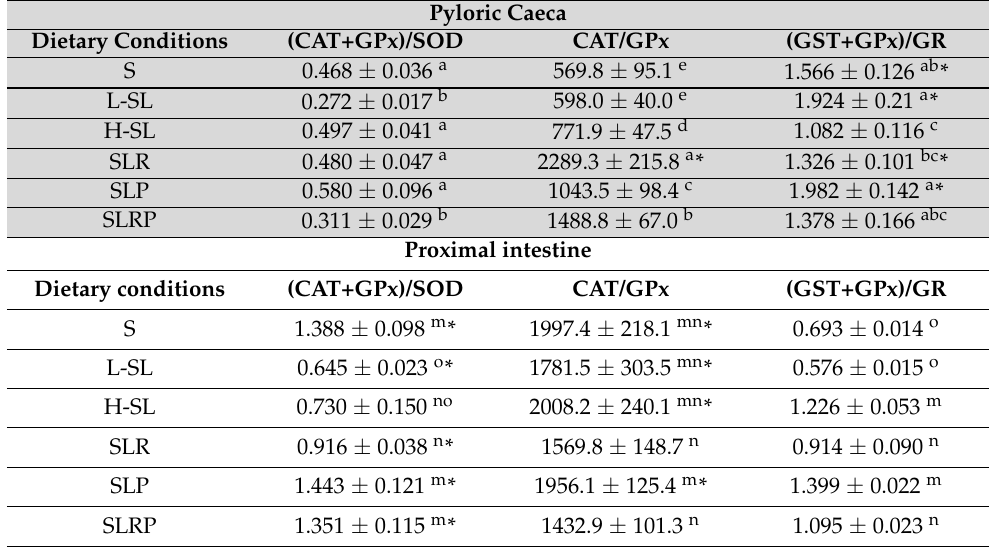
Table 7. Ratios of antioxidant enzymes activities (CAT+GPx)/SOD, CAT/GPx and (GST+GPx)/GR ratios in pyloric caeca and proximal intestine 24 h post feeding in sea bream fed the experimental diets. Pyloric Caeca Dietary Conditions (CAT+GPx)/SOD CAT/GPx (GST+GPx)/GR S 0.468 ± 0.036 a 569.8 ± 95.1 e 1.566 ± 0.126 ab * L-SL 0.272 ± 0.017 b 598.0 ± 40.0 e 1.924 ± 0.21 a * H-SL 0.497 ± 0.041 a 771.9 ± 47.5 d 1.082 ± 0.116 c SLR 0.480 ± 0.047 a 2289.3 ± 215.8 a * 1.326 ± 0.101 bc * SLP 0.580 ± 0.096 a 1043.5 ± 98.4 c 1.982 ± 0.142 a * SLRP 0.311 ± 0.029 b 1488.8 ± 67.0 b 1.378 ± 0.166 abc Proximal intestine Dietary conditions (CAT+GPx)/SOD CAT/GPx (GST+GPx)/GR S 1.388 ± 0.098 m * 1997.4 ± 218.1 mn * 0.693 ± 0.014 o L-SL 0.645 ± 0.023 o * 1781.5 ± 303.5 mn * 0.576 ± 0.015 o H-SL 0.730 ± 0.150 no 2008.2 ± 240.1 mn * 1.226 ± 0.053 m SLR 0.916 ± 0.038 n * 1569.8 ± 148.7 n 0.914 ± 0.090 n SLP 1.443 ± 0.121 m * 1956.1 ± 125.4 m * 1.399 ± 0.022 m SLRP 1.351 ± 0.115 m * 1432.9 ± 101.3 n 1.095 ± 0.023